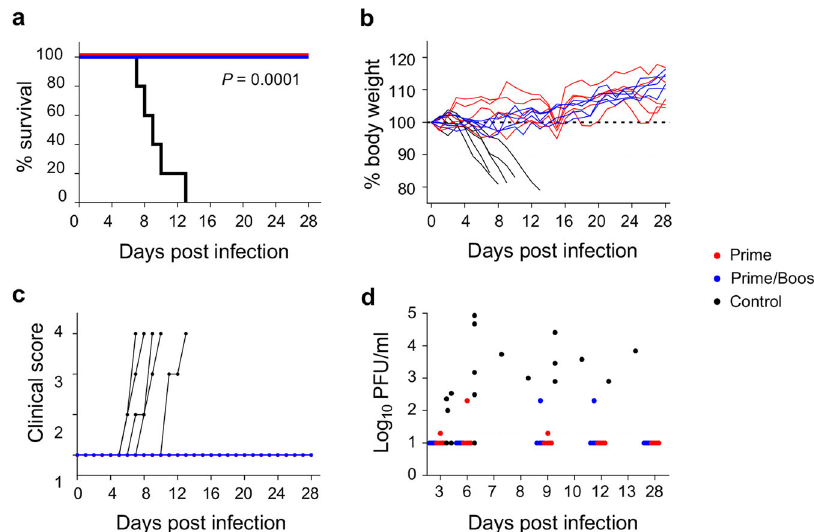
Fig. 6 MVA-VLP-SUDV protects from death and disease caused by SUDV. Guinea pigs were vaccinated with the indicated vaccines: a survival, b weight loss, c disease scores, and d viremia following challenge with guinea pig-adapted SUDV are displayed. The prime group is in red, the prime/boost group in blue, and the control group in black. N = 5 animals per group. Survival: P = 0.0001 control animals versus vaccinated animals, Log-rank Mantel-Cox